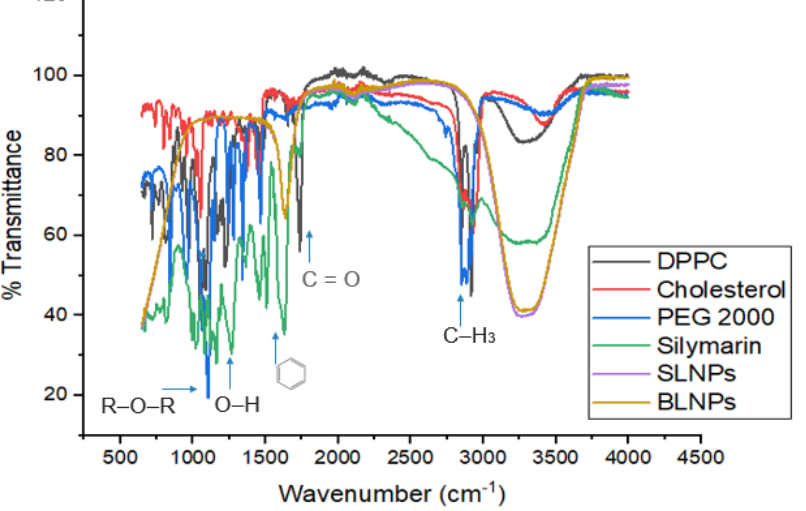
Figure 2. Comparative FTIR spectra of DPPC, cholesterol, PEG − 2000, silymarin, silymarin LNPs, and blank LNPs, using a Bruker FTIR spectrophotometer ALPHA II (Westborough, MA, USA).